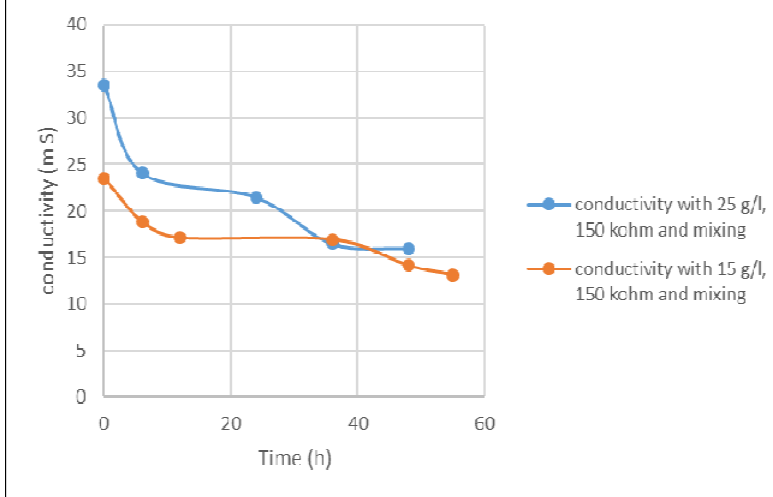
Fig. 5. shown the conductivity of the MDC using mixing in the desalination